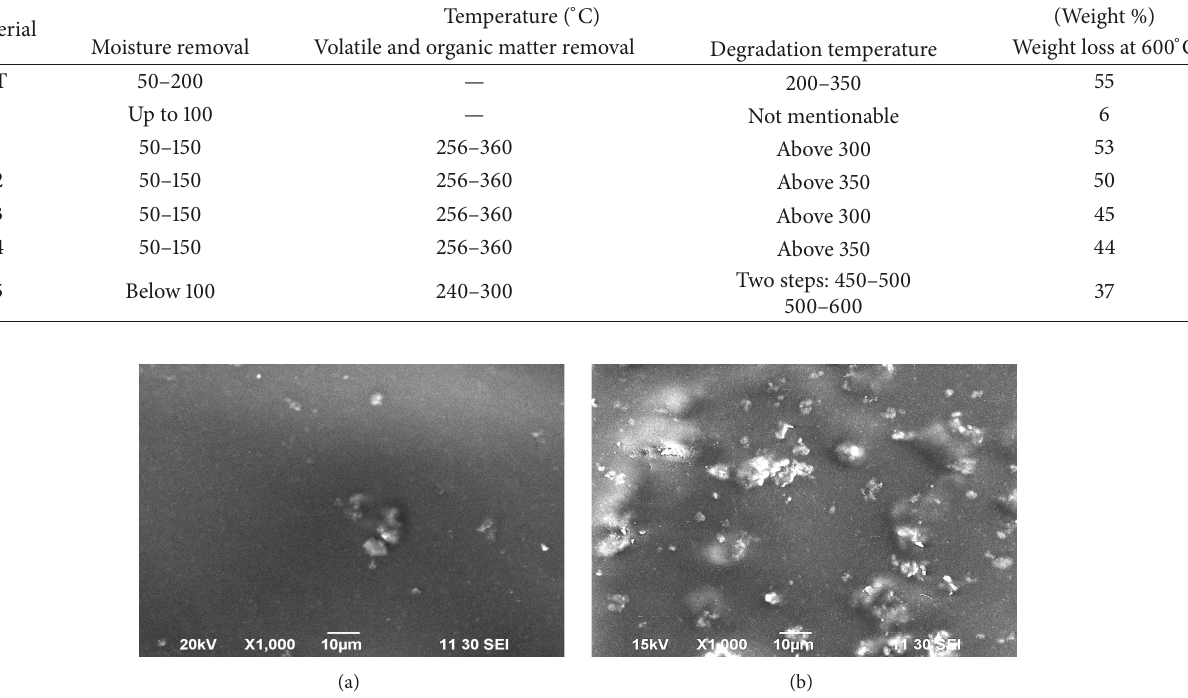
Figure 8: SEM images of the surface of CHT-MC composites; (a) SB-1 and (b)